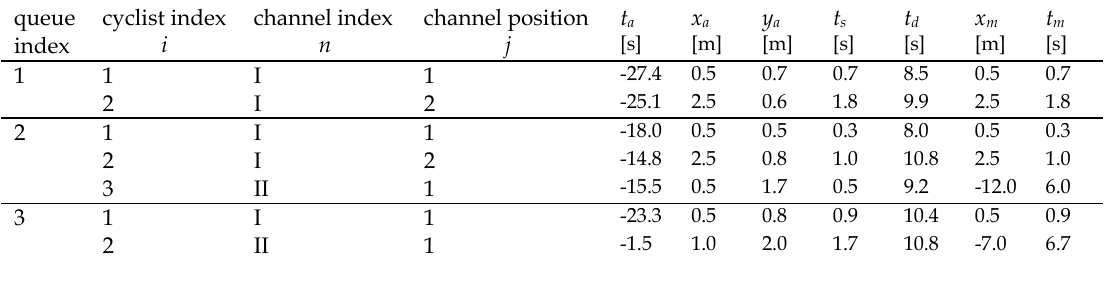
Sample observations